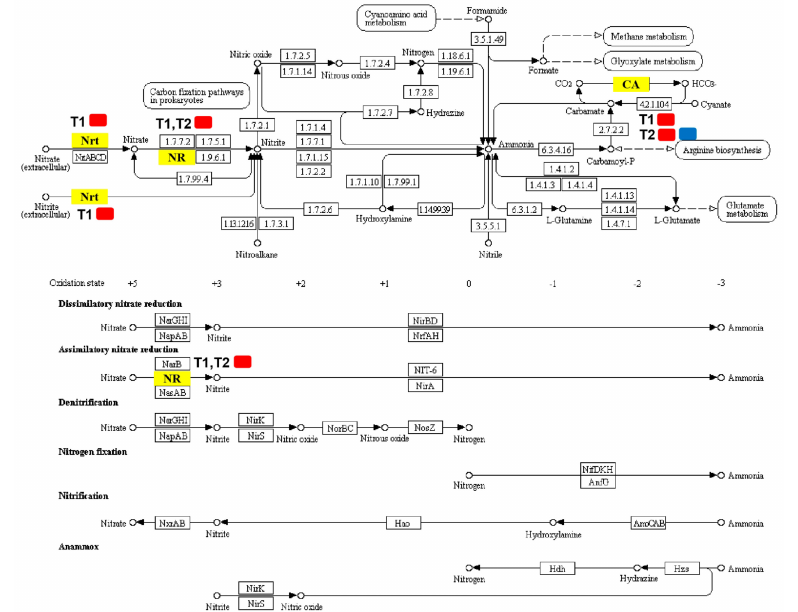
Figure6. PathwaysmapofDEGsannotatedinnitrogenmetabolism. Yellowboxesrepresentsignificantly regulated DEGs annotated in T1 / CK and T2 / CK. Red represents a high expression level and blue represents a low expression level. Nrt (High-a ffi nity nitrate transporter 2.2; MELO3C000140.2) was upregulated in T1; NR (Nitrate reductase; MELO3C010444.2) was upregulated in both T1 and T2; CA included alpha carbonic anhydrase (MELO3C009476.2), which was upregulated in both T1 and T2, and alpha carbonic anhydrase 7-like (MELO3C024476.2), which was downregulated only in